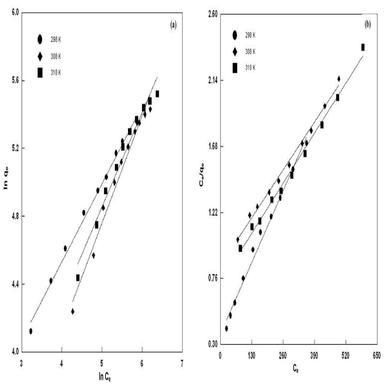
(a) Freundlich, (b) Langmuir plots of 2,4-D adsorption onto FLPWAC composite.